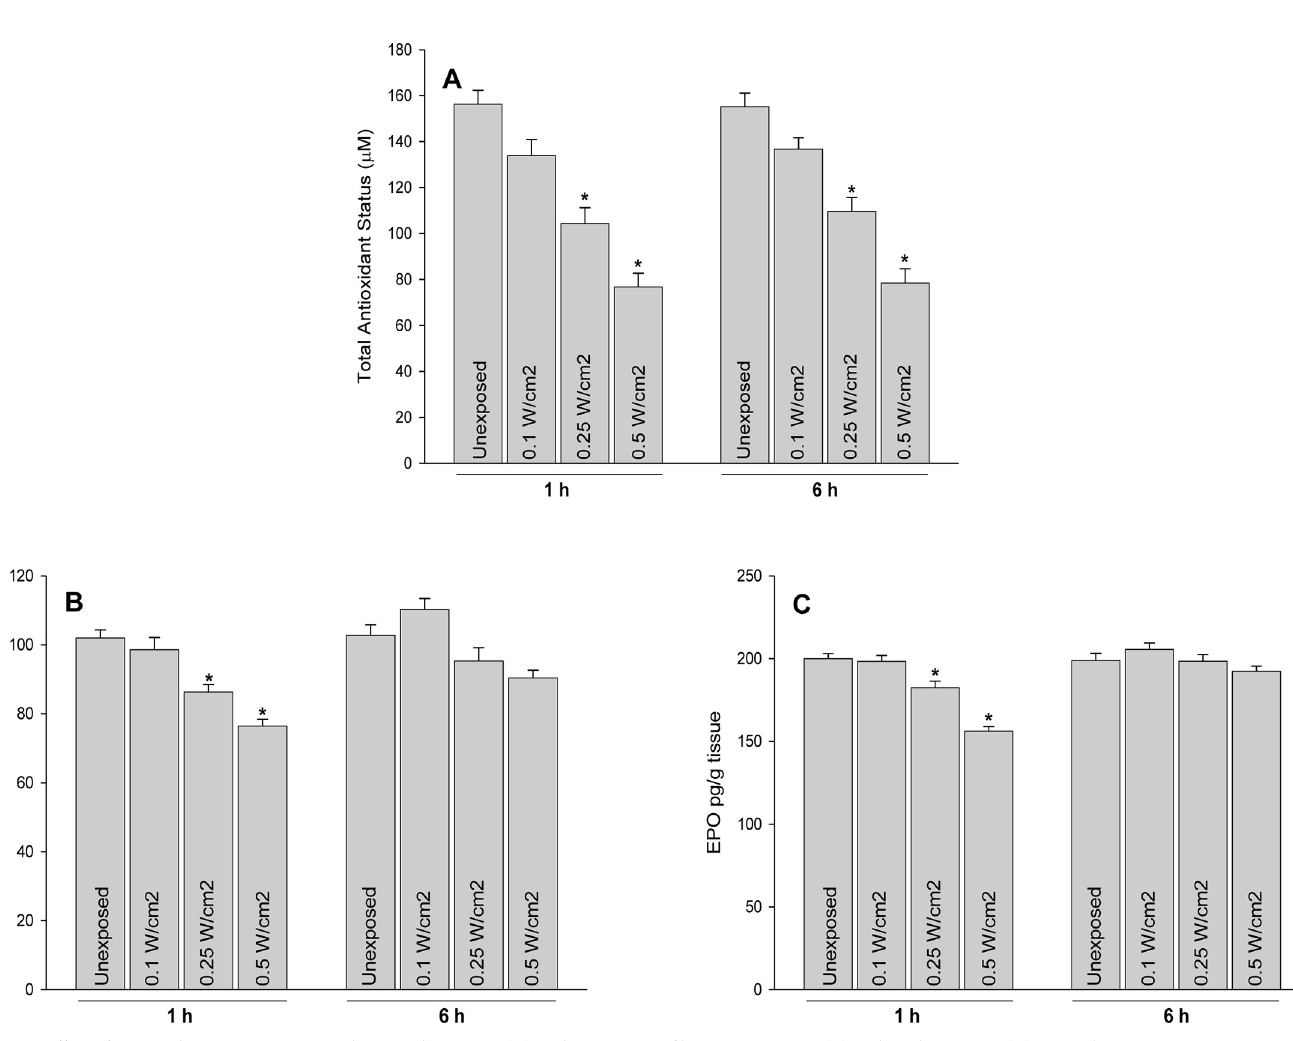
Fig 10. Effect of 532 nm laser exposure on total antioxidant status (A) and expression of hemeoxygenase 1 (B) and erythropoietin (C) in rat skin. � p < 0.05. https://doi.org/10.1371/journal.pone.0230175.g010 PLOS ONE | https://doi.org/10.1371/journal.pone.0230175 March 19,